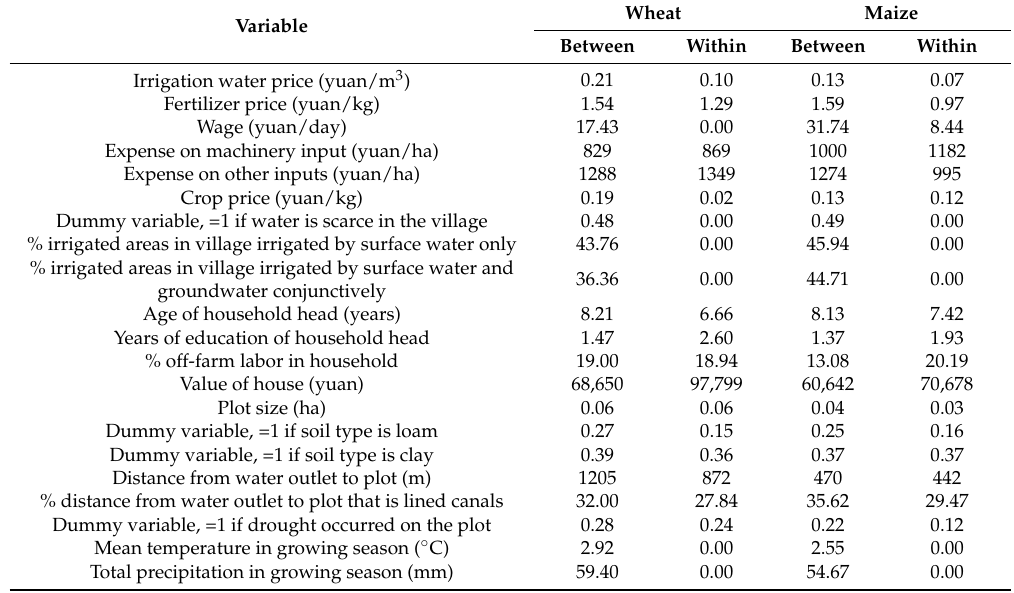
Table A1. Decomposition of key variables’ variation on village level for wheat and maize,